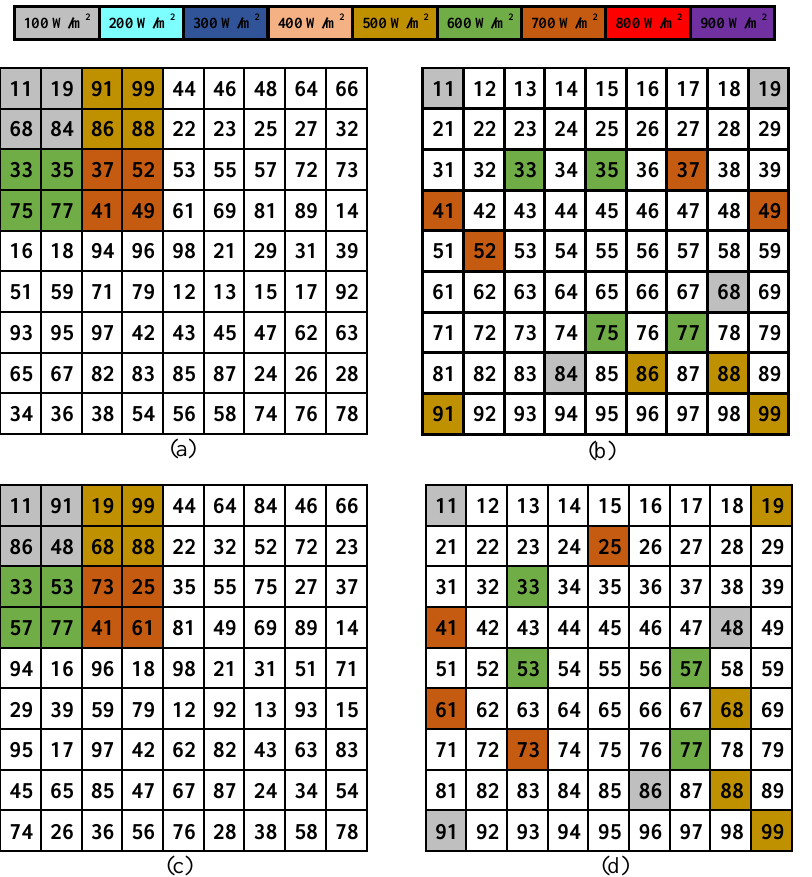
Figure 2. ( a ) OEP ( b ) Shade dispersion of OEP ( c ) IOEP ( d ) Shade dispersion of Improved Odd–Even– Prime for 9 × 9 Top-Left